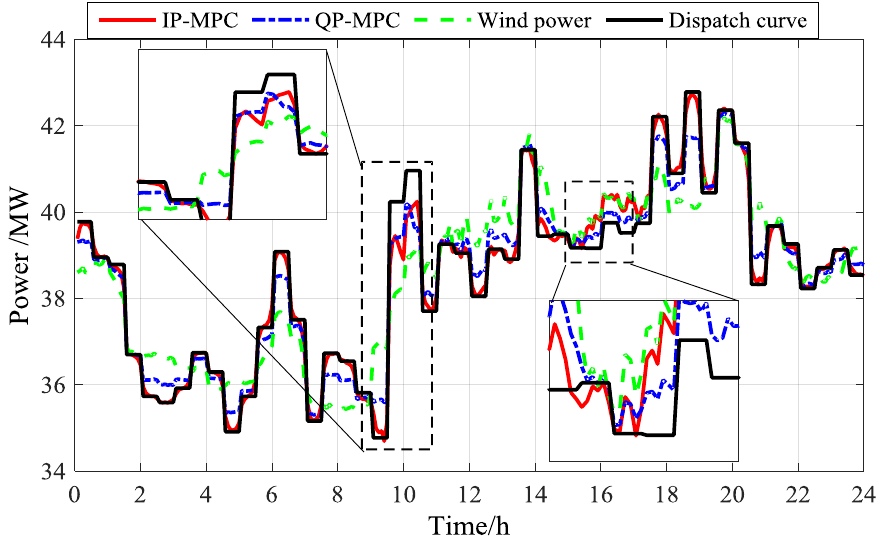
Figure 5. Wind power and dispatch power (4.5 MWh).